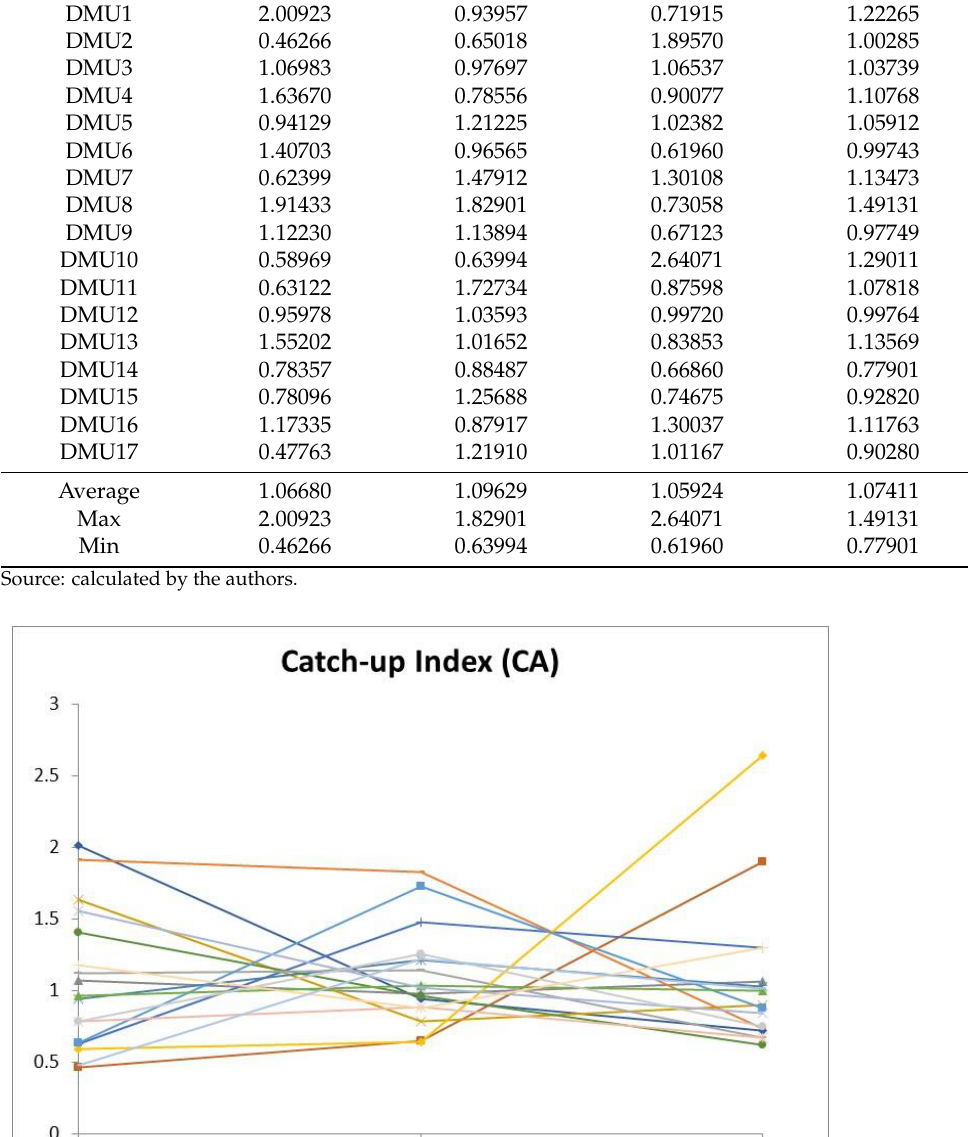
Table 6. Catch-up index (efficiency change).